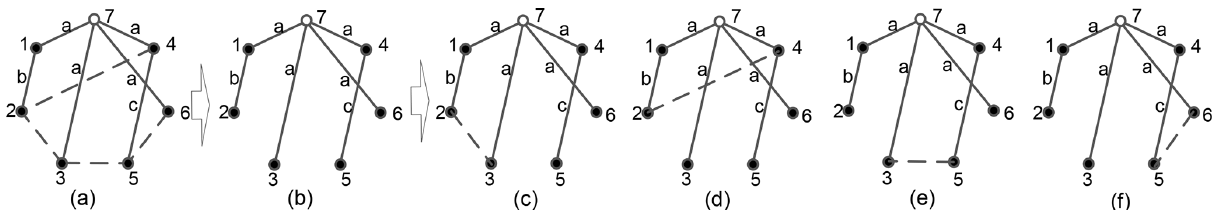
Figure 2. (a) The tree and basic loops of the Simpson gear train. (b) The tree of the Simpson gear train, (c) basic loop f 1 , (d) basic loop f 2 , (e) basic loop f 3 , and (f) basic loop f 4